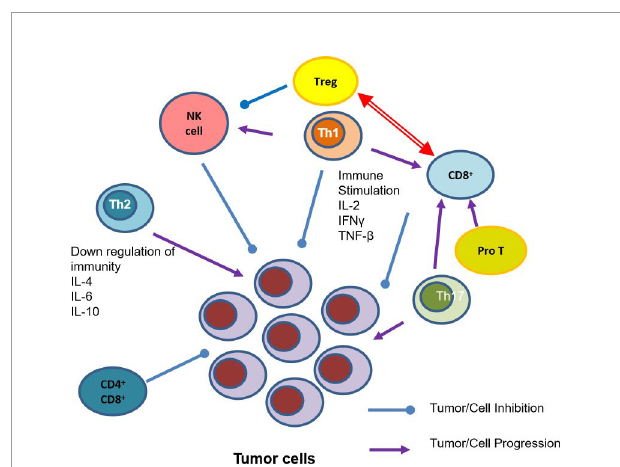
FIGURE 2 | T Cell Subsets and their role in Tumor Inhibition and Progression. IFN- g , Interferon- g ; IL-2, Interleukin-2; IL-4, Interleukin-4; IL6, Interleukin-6; IL-10, Interleukin-10; NK cell, natural killer cells; Pro T, T lineage progenitor; Th1, T helper cell 1; Th2, helper T cell 2; Th17, helper cell type 17; TNF- b , Tumor necrosis factor- b ; Tregs, regulatory T